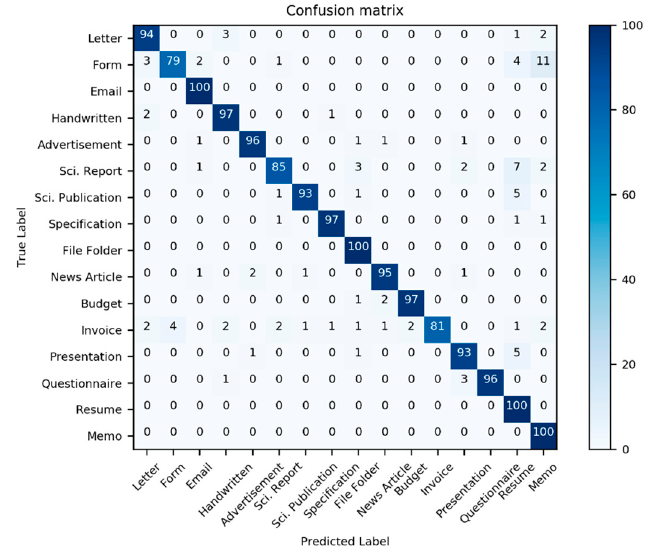
Figure 13. Confusion matrix of the performance results of model IV for 1600 test data from the dataset Haley et al. [59]. (Source: our own images).